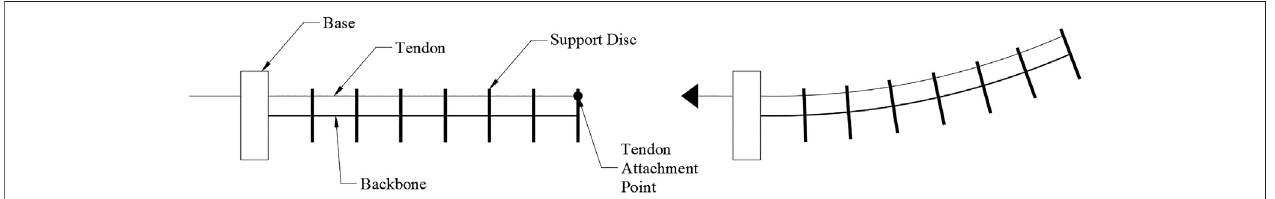
FIGURE 3 | Single tendon continuum robot actuation ( left -no tension in the tendon, right – tendon in tension).